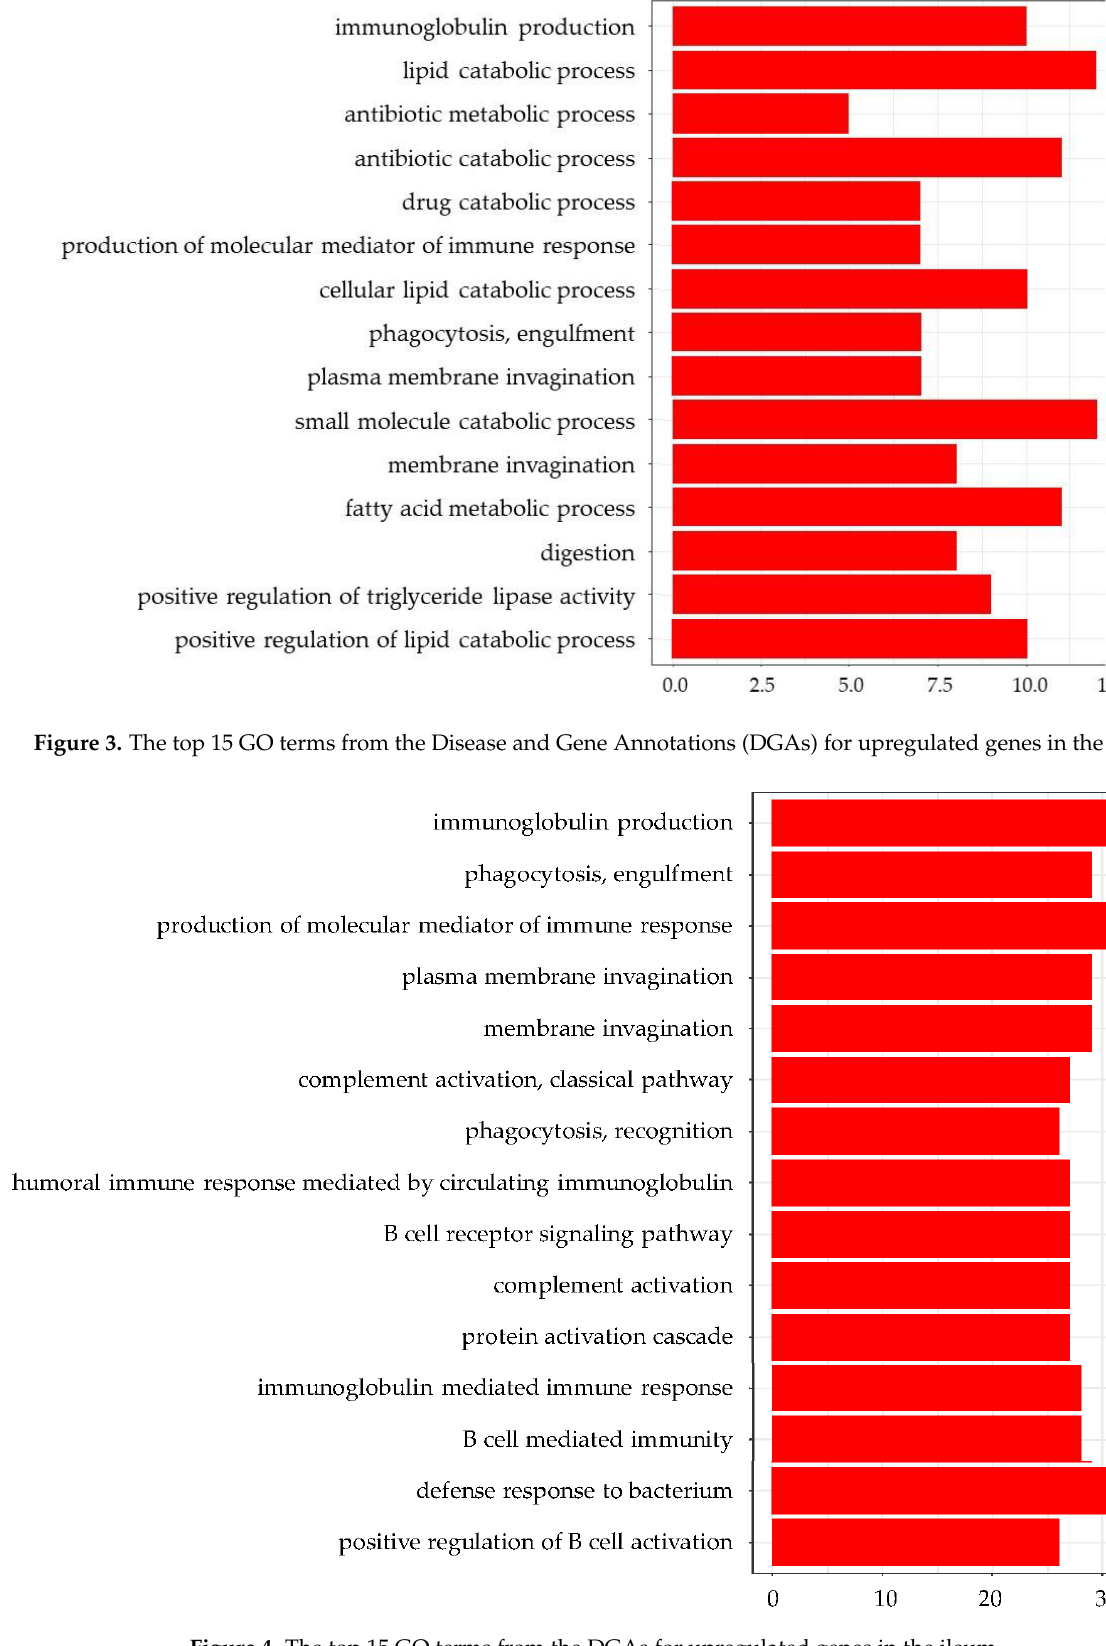
Figure 5. The top 15 GO terms from the DGAs for downregulated genes in the ileum.